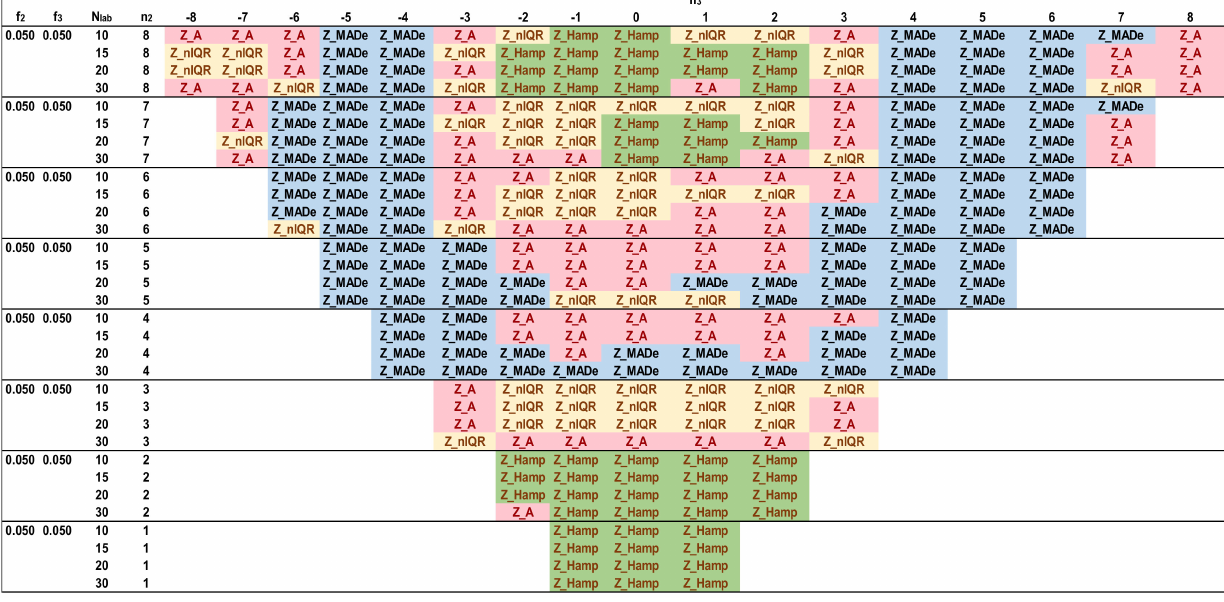
Figure 15. Optimal robust estimators of Zu% for trimodal distributions, f 2 = 0.05 and f 3 =